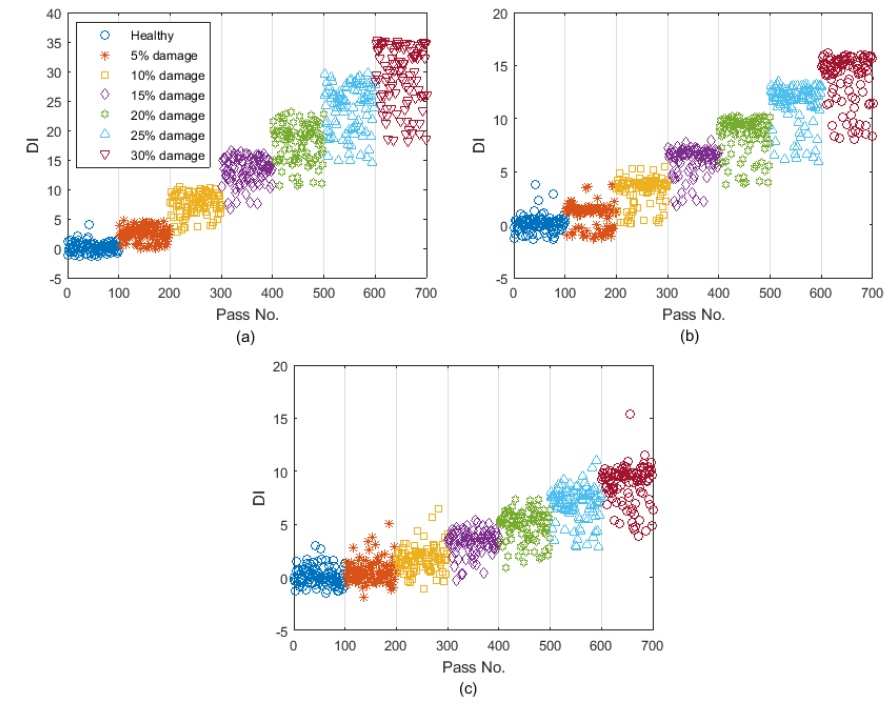
Figure 10. The DIs for ( a ) 1% added noise; ( b ) 3% added noise; and ( c ) 5% added noise.